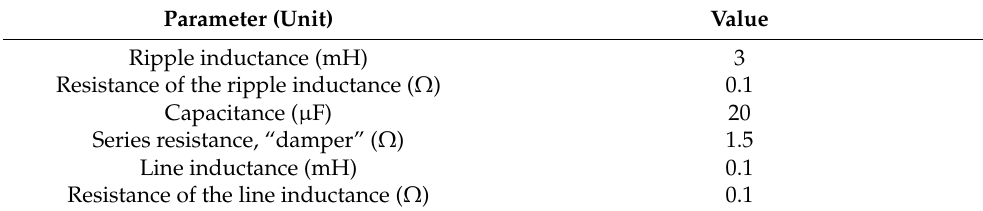
Table 3. Parameters of the LCL filter at the inverter battery output.